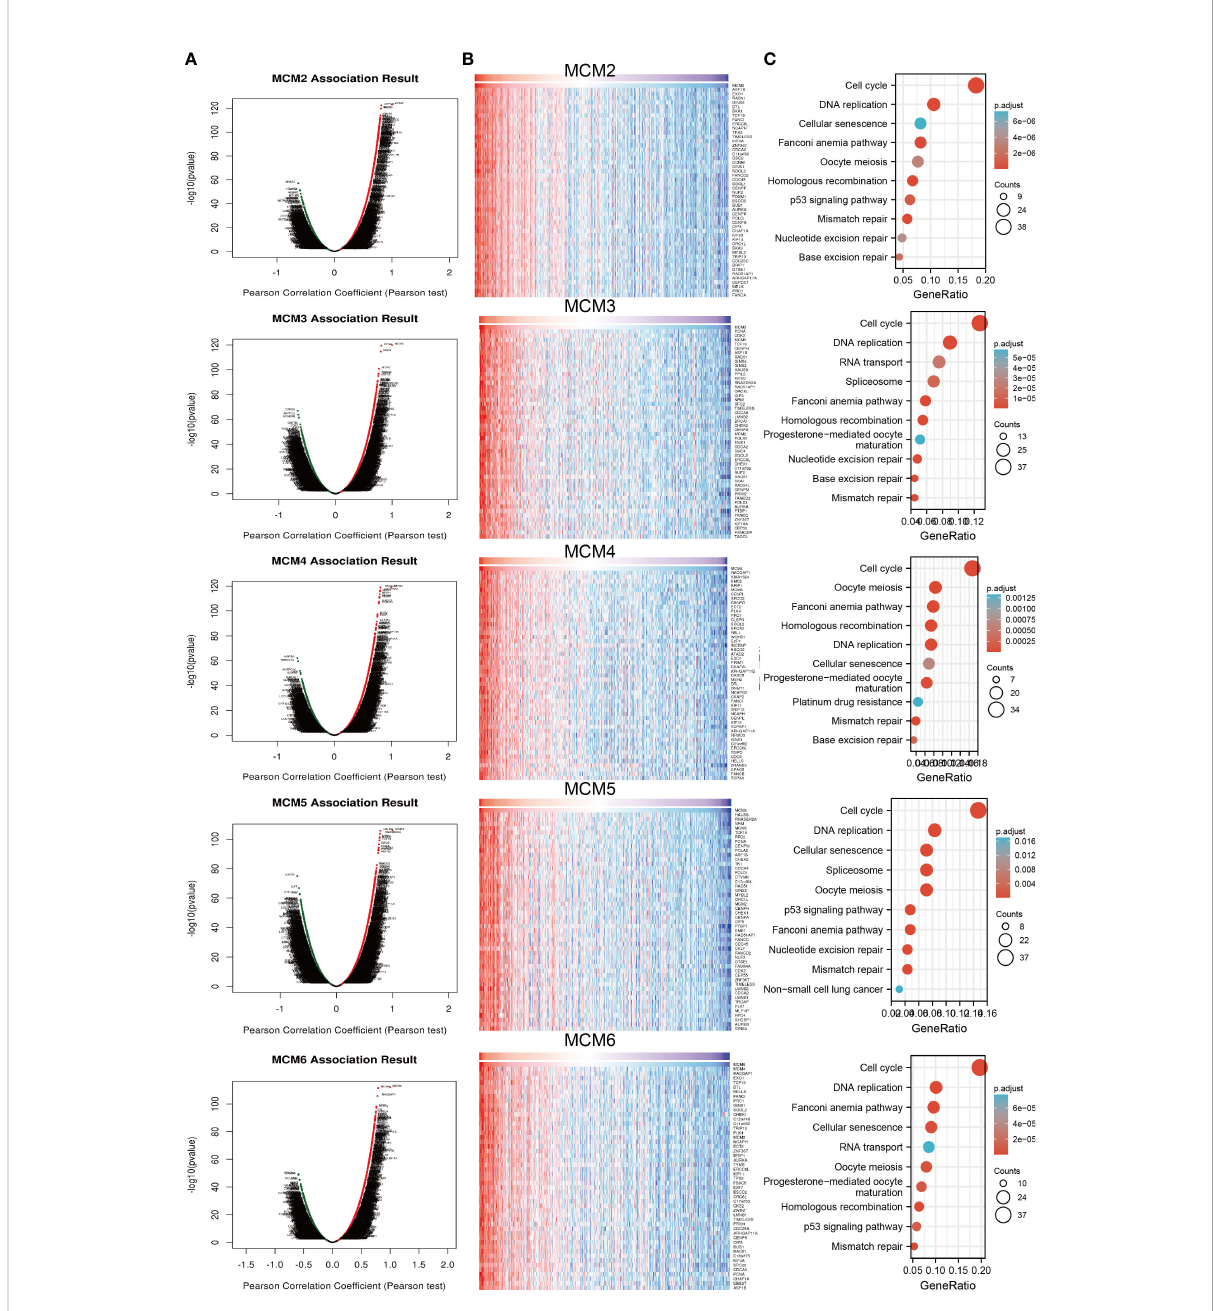
FIGURE 11 Analysis of the function of MCMs in glioma. (A, B) Analysis of co-expression genes of MCMs in glioma by link omics database. (C) KEGG enrichment is the signaling pathway of MCMs in glioma. KEGG, Kyoto Encyclopedia of Genes and